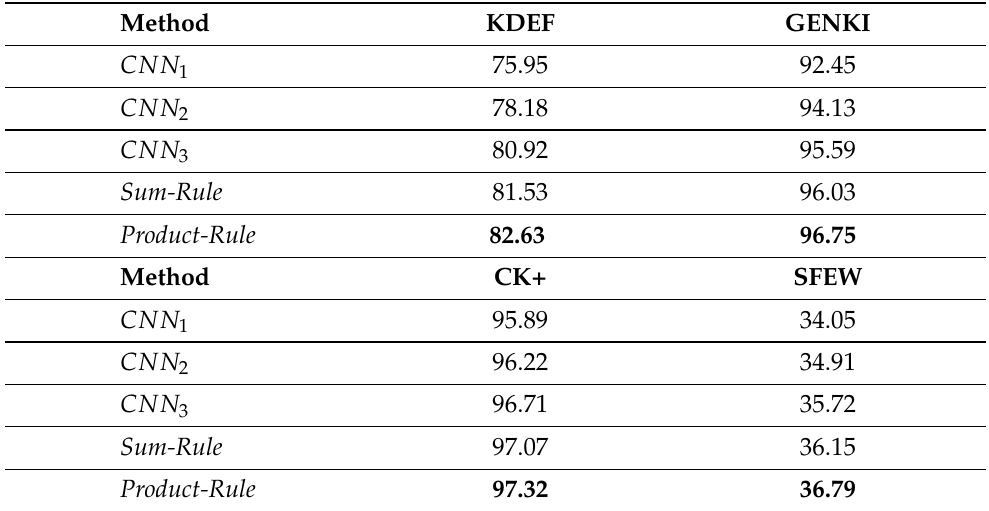
Table 6. Effect of score-level fusion approaches on the performance of the proposed